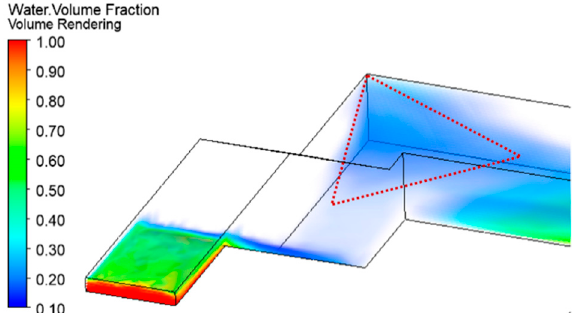
Figure 15. Volume rendering of accumulated water in the Exit 4 passage.